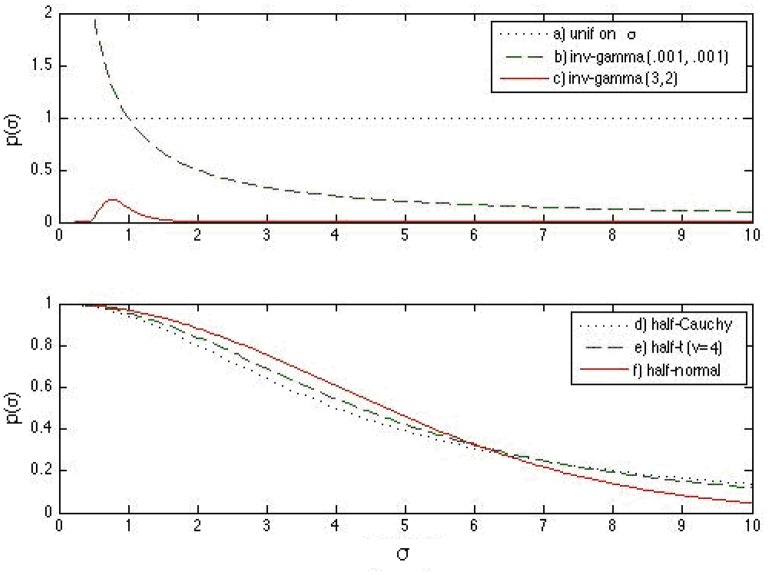
Prior density functions for the slope and intercept standard deviation parameters: (a) uniform prior distribution on σα (or σβ), (b) inverse-gamma (0.001, 0.001) prior distribution on σα2 (or σβ2), (c) inverse-gamma (3, 2) prior distribution on σα2 (or σα2), (d) half-Cauchy prior distribution for σα (or σβ), (e) half-t prior distribution for σα (or σβ) with 4 degrees of freedom, and (f) half-normal prior distribution for σα (or σβ). It is noted that the half-t distributions are on a different scale compared to the previous three densities.